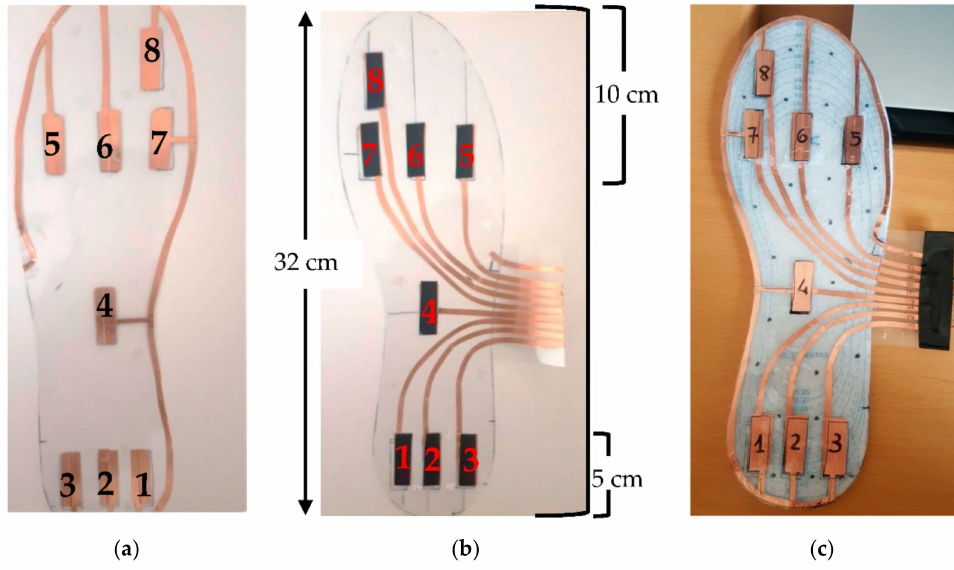
Figure 19. View of the sensing matrix’s prototype consisting of 8 piezoresistive sensors before assembly: top layer ( a ); bottom layer ( b ); and assembled sensing matrix ( c